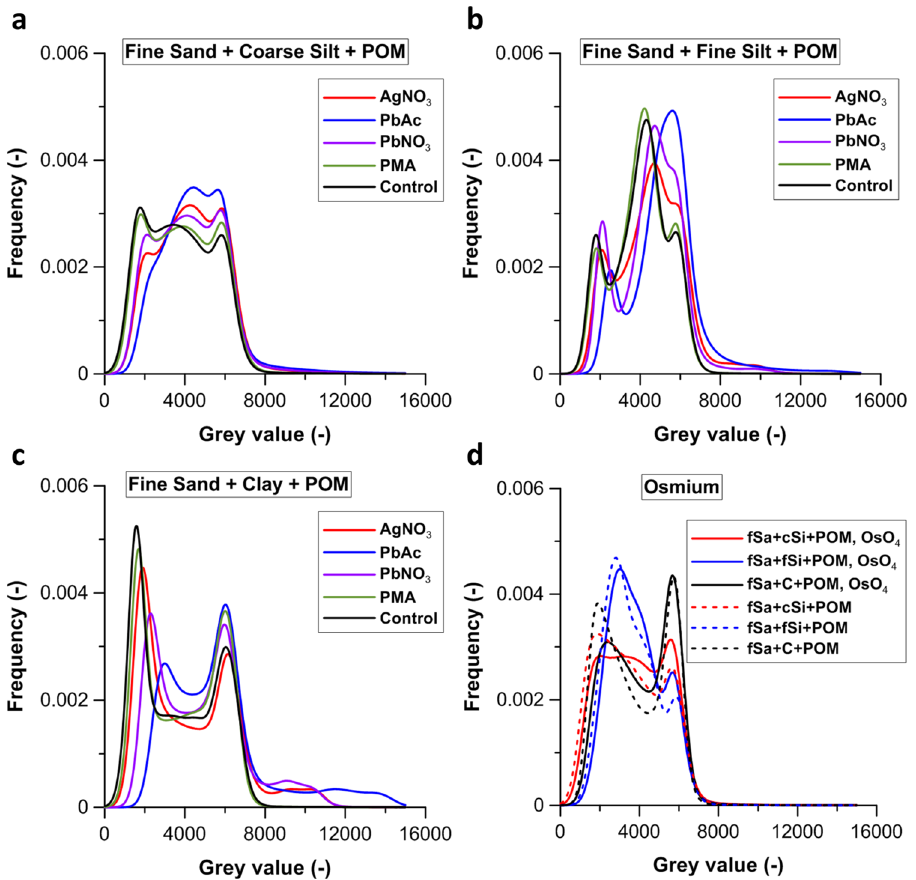
Figure 2. Grey scale histogram (0–16,000) for 16 bit images of ( a ) the fine sand + coarse silt + POM soil samples, ( b ) the fine sand + fine silt + POM mixtures and ( c ) the fine sand + clay + POM mixtures. The unstained control treatment (black) and the stained AgNO 3 (red), PbAc (blue), Pb(NO 3 ) 2 (purple) and PMA (green) treatments. ( d ) Grey scale histogram (0–16,000) for 16 bit images of OsO 4 stained fine sand + coarse silt + POM (fSa + cSi + POM; red), fine sand + fine silt + POM (fSa + fSi + POM; blue) and fine sand + clay + POM (fSa + C + POM; black) mixtures. The equivalent control treatments are indicated by dotted